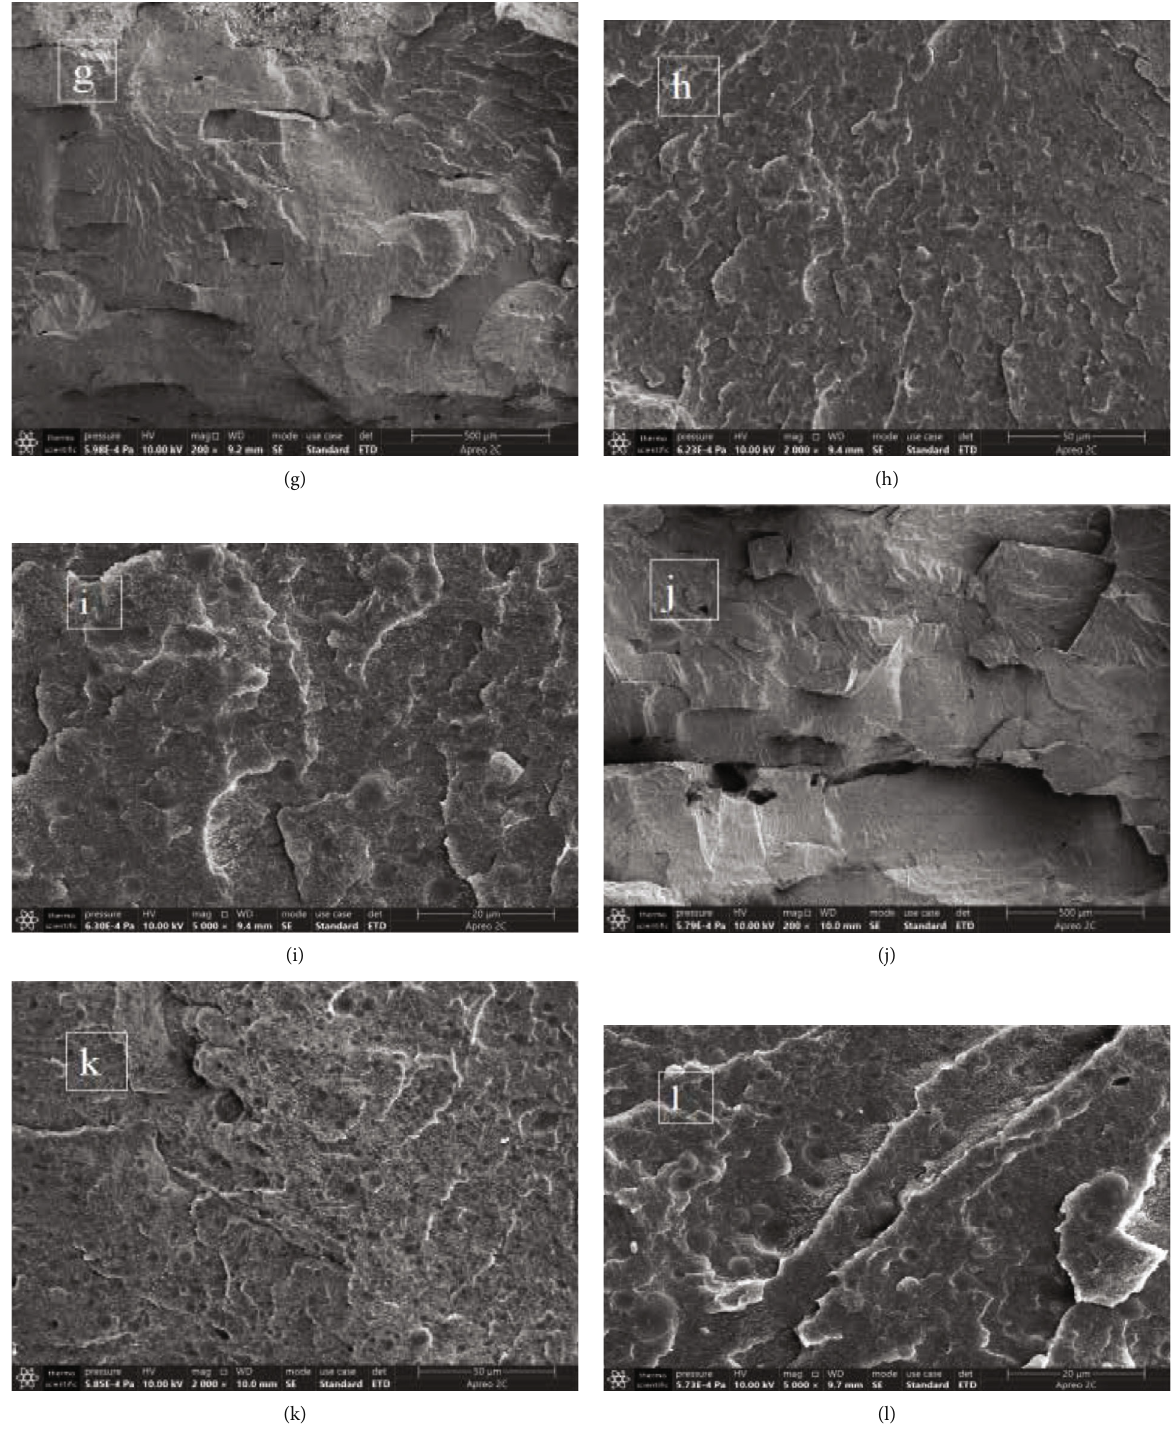
Figure 8: SEM photographs of PP-g-MAH1 at the magni fi cation of 200 (a), 2000 (b), and 5000 (c); PP-g-MAH2 at the magni fi cation of 200 (d), 2000 (e), and 5000 (f); PP-g-MAH3 at the magni fi cation of 200 (g), 2000 (h), and 5000 (i); and PP-g-MAH5 at the magni fi cation of 200 (j), 2000 (k), and 5000